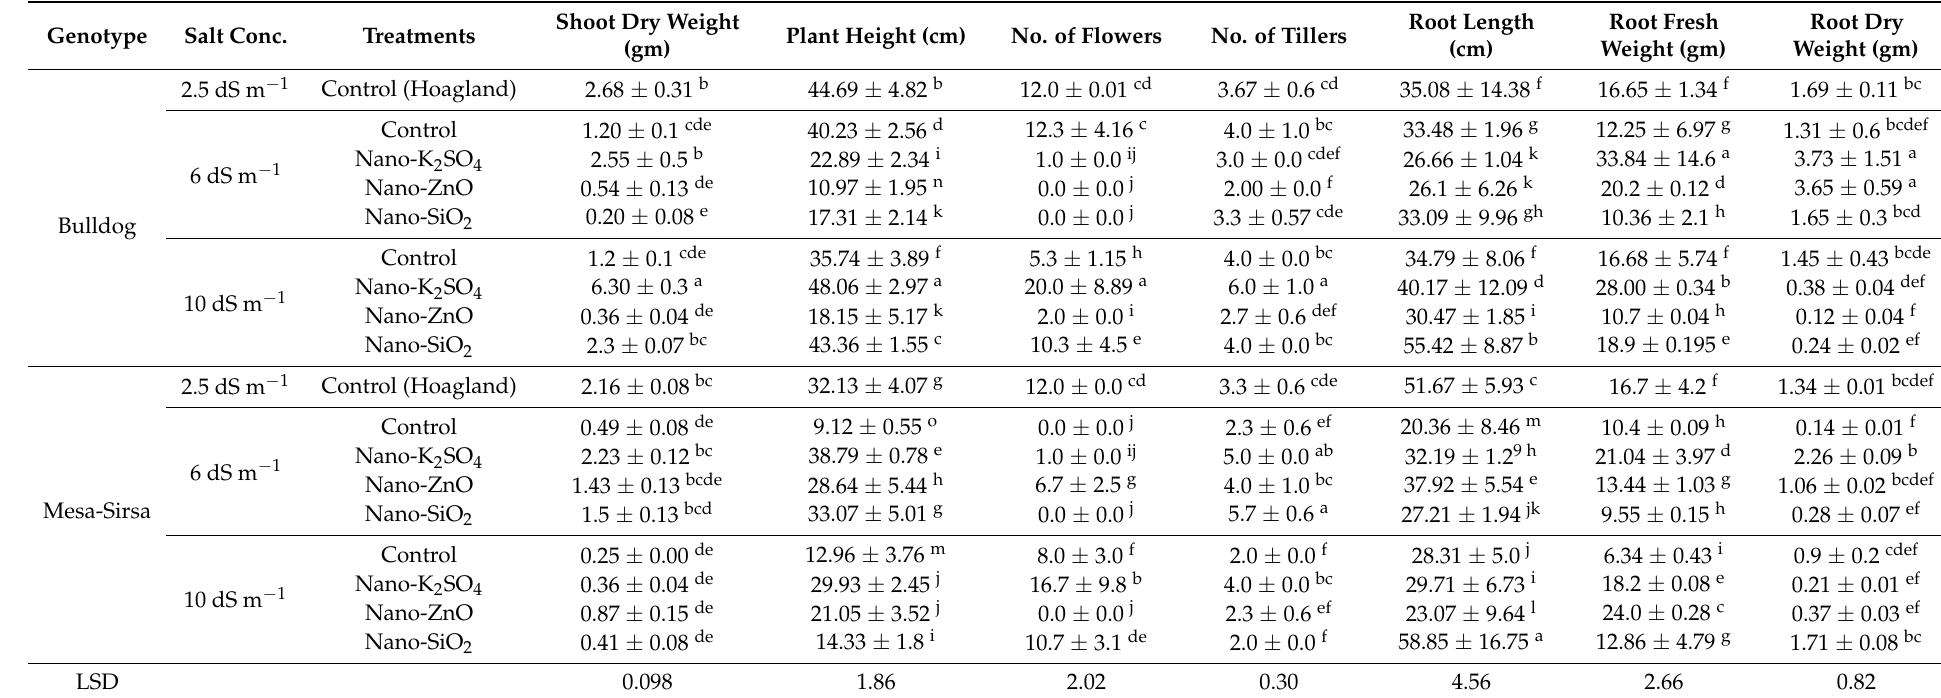
Table 1. Different traits of alfalfa genotypes as affected by three salt levels and different nano-fertilizers.